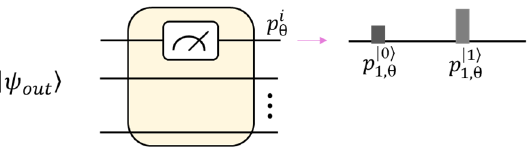
Figure 3. Quantum circuit and measurement to obtain observation probability for regression prob-